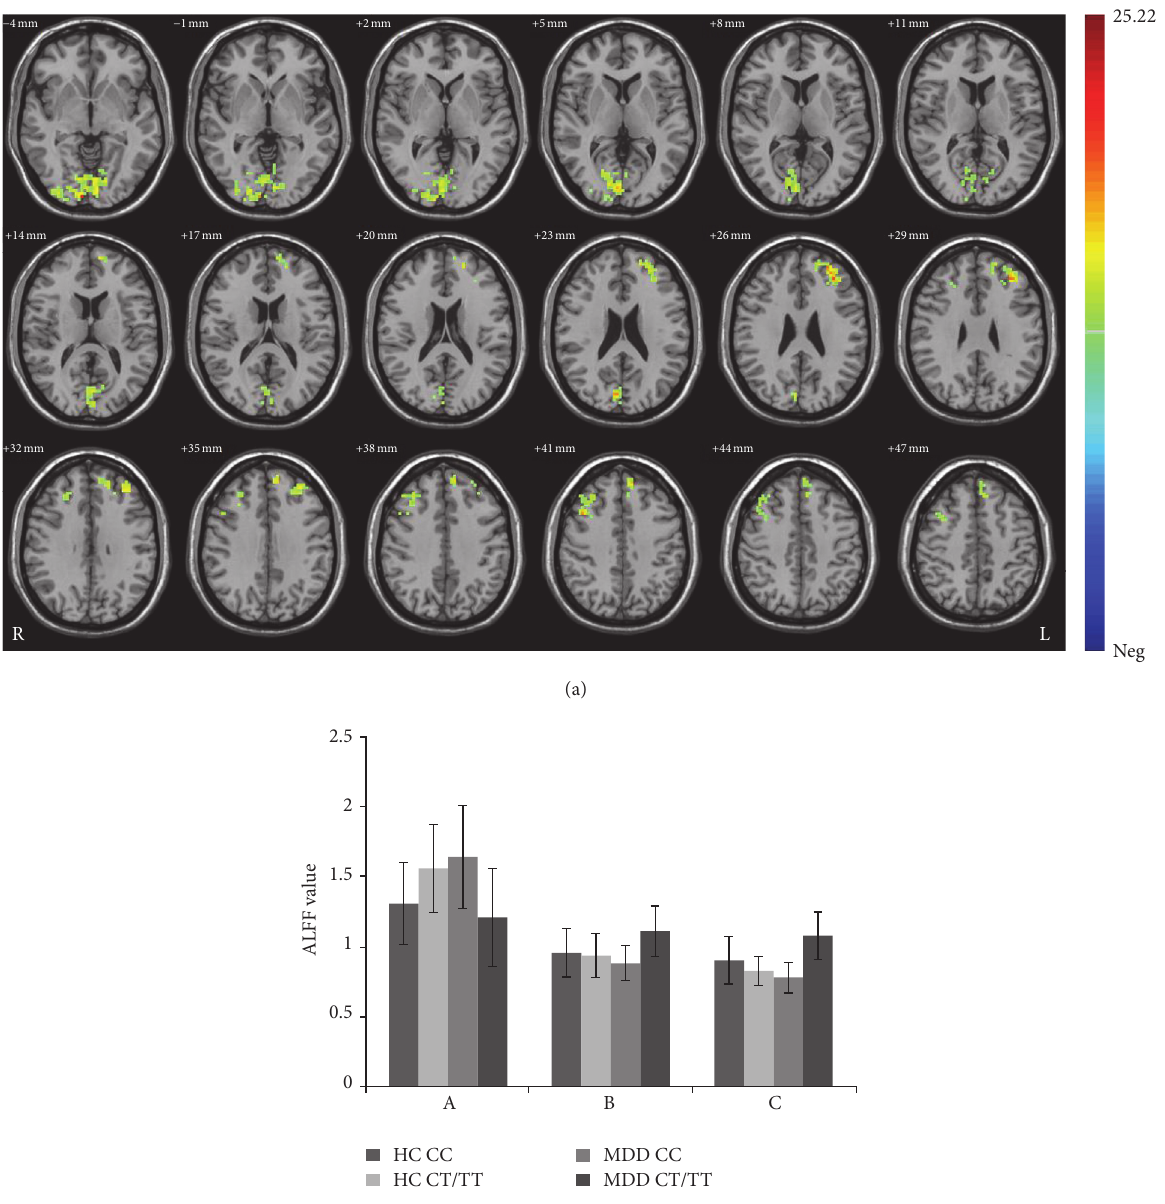
Figure 3: Interaction between rs35936514 genotypes and diagnosis. (a) Clusters of significance for the interaction effect in the bilateral lingual gyri, bilateral dlPFC, and left mPFC ( 𝑃 < 0.05 by AlphaSim correction, and 123 voxels minimum). Color bar represents the range of 𝐹 values. (b) Interaction graph showing the ALFF value was (A) decreased in bilateral lingual gyri and (B) increased in the left dlPFC and mPFC and (C) right dlPFC, in MDD patients with CT/TT